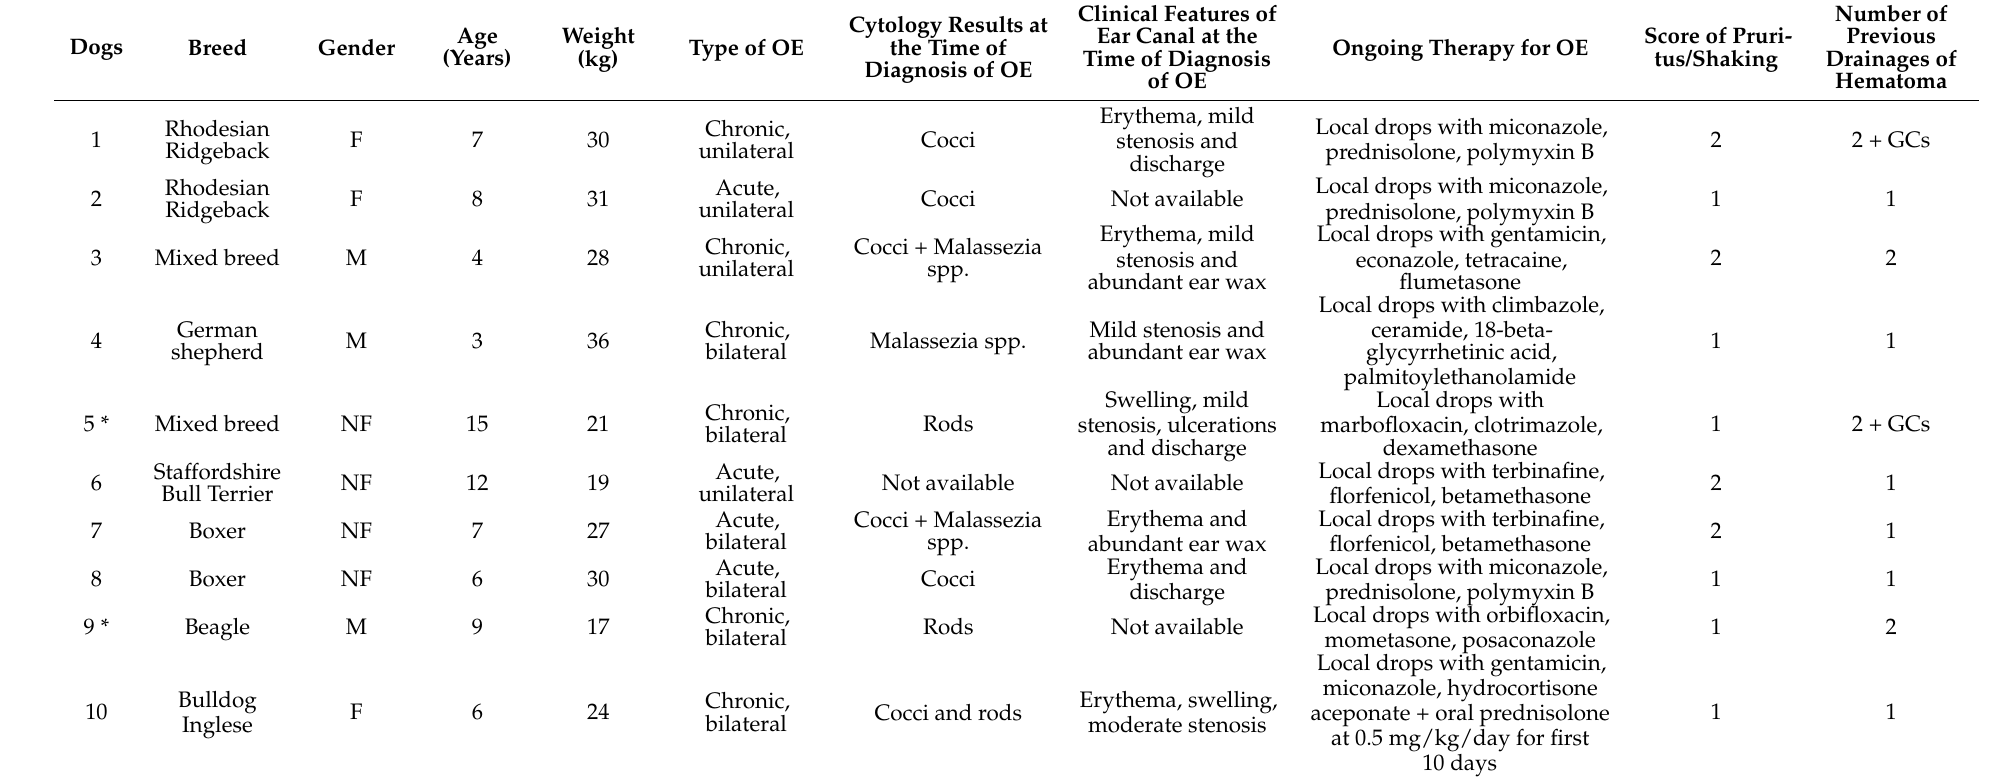
Table 1. Descriptive data for each dog. The dogs marked with (*) did not complete the clinical